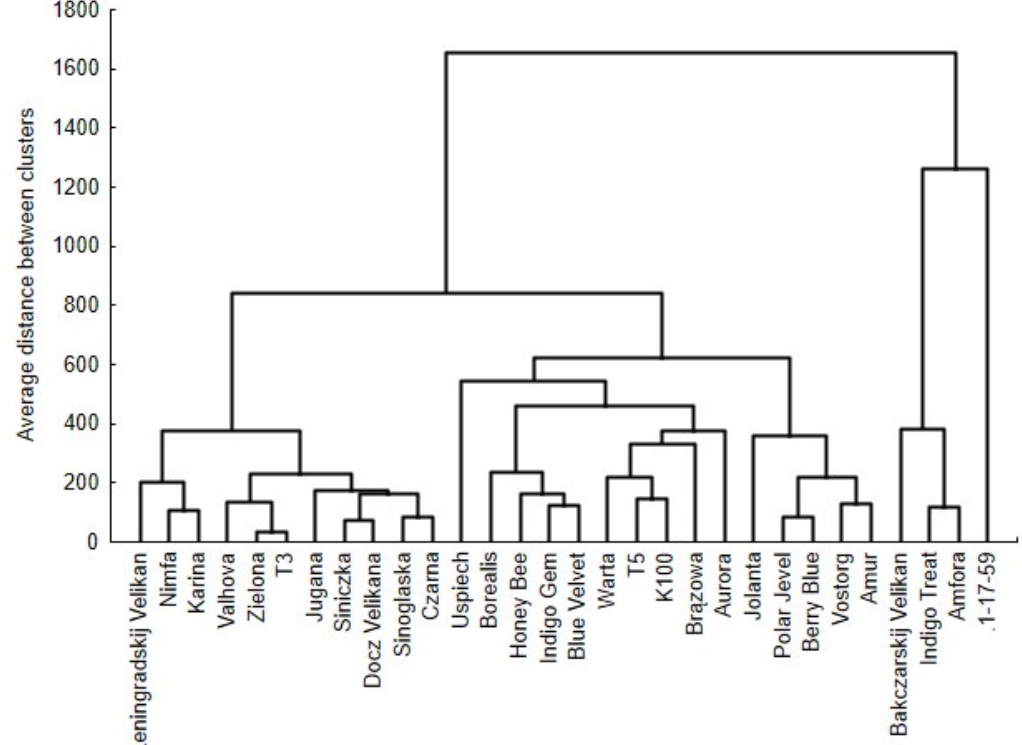
Figure 1. Dendrogram estimating distance among 30 blue honeysuckle genotypes based on phenolic acid, flavonoid, vitamin C content and antioxidant activity. Table 4. Estimates of variance, heritability (H) and genetic advance of fruit phytochemical content and antioxidant activity in 30 blue honeysuckle genotypes.